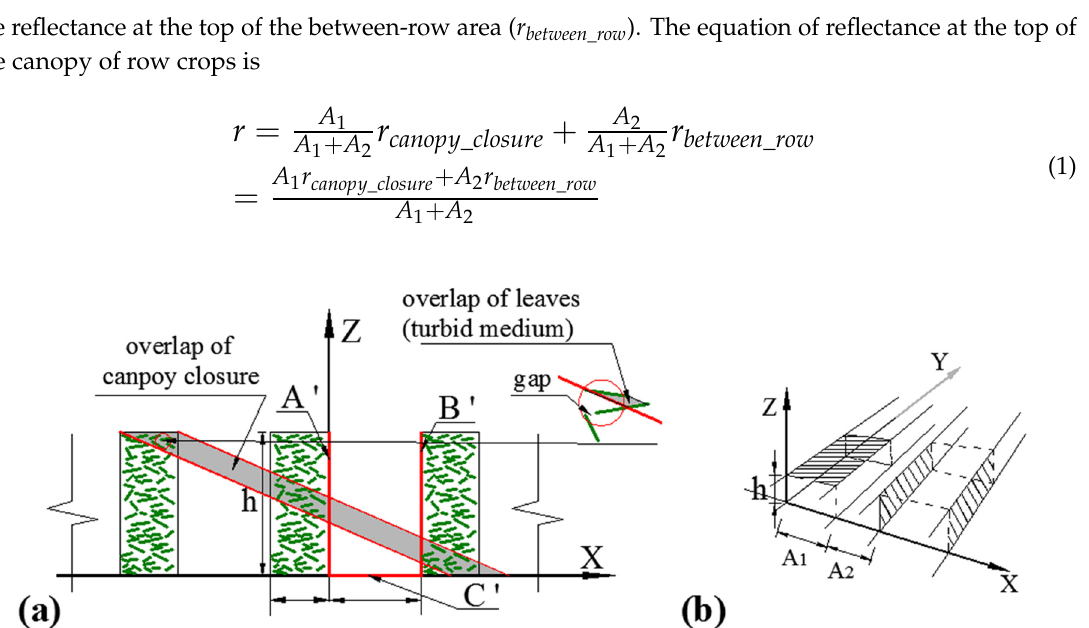
Figure 1. Sketch of the scene of row crops. ( a ) Overlapping relationship between leaves and canopy closures involved in the calculation of gap probabilities; ( b ) three-dimensional map of row crops. Here, A 1 is the row width, A 2 is the between-row distance, and h is the canopy height.